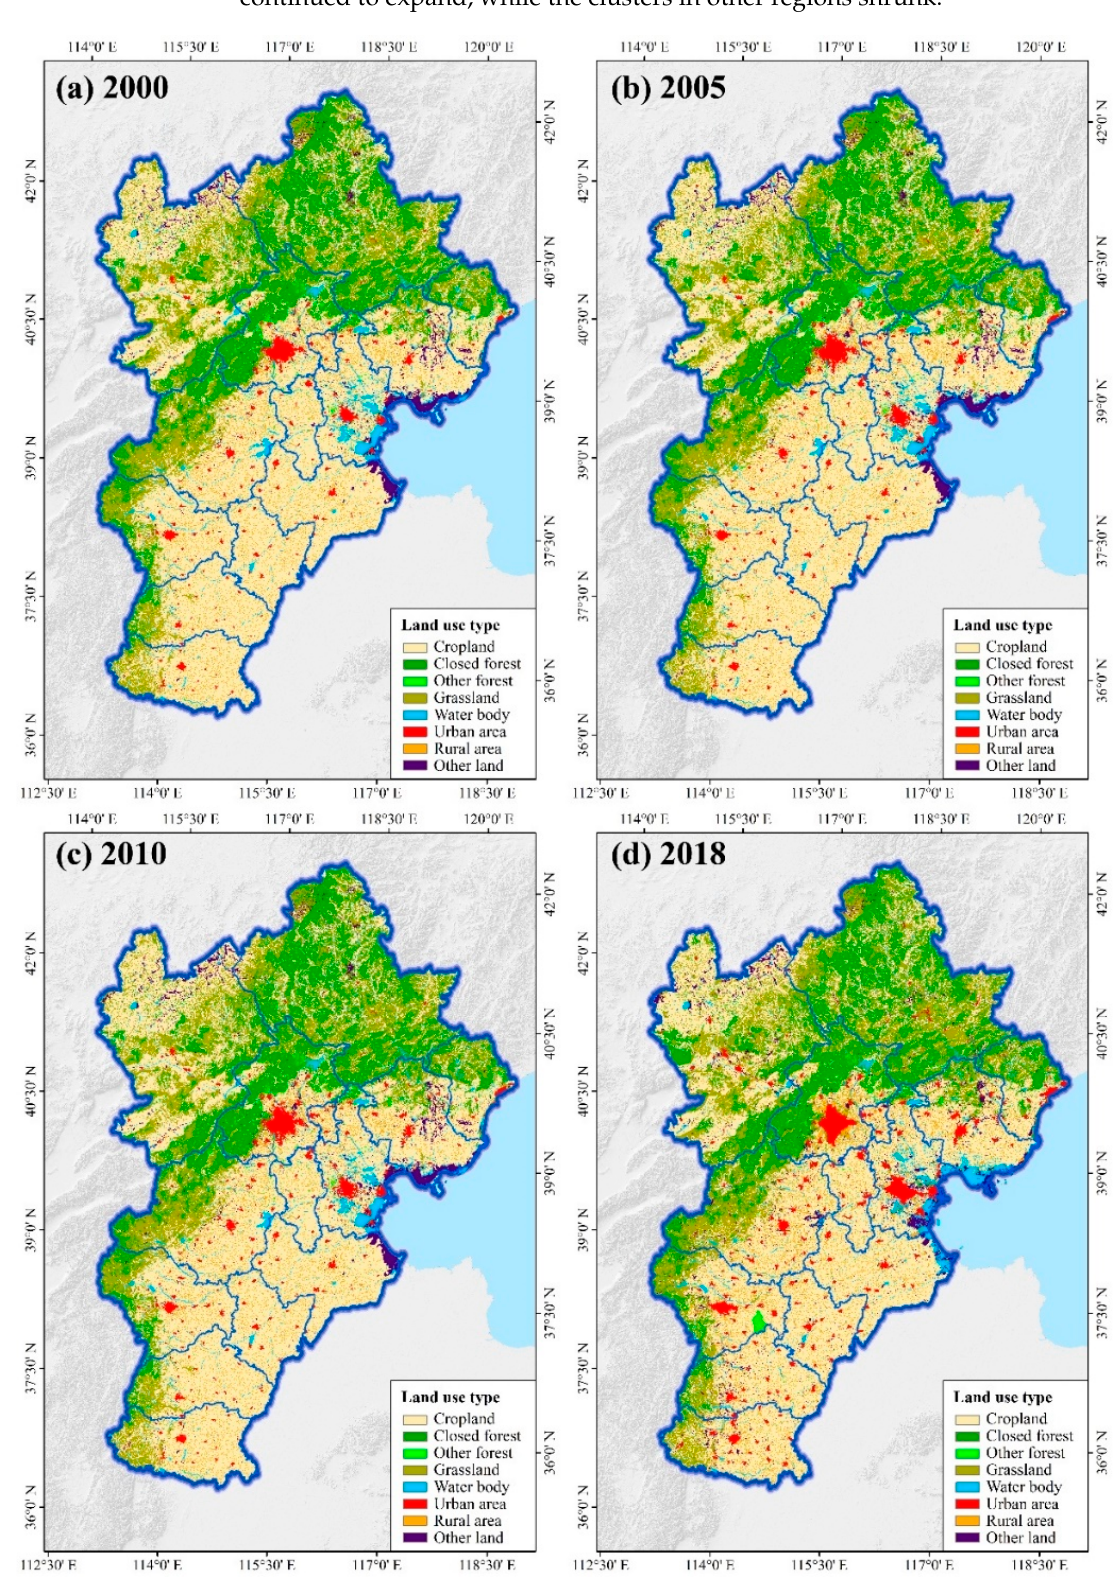
Figure 4. The LUCC in Beijing–Tianjin–Hebei from 2000 to 2018.